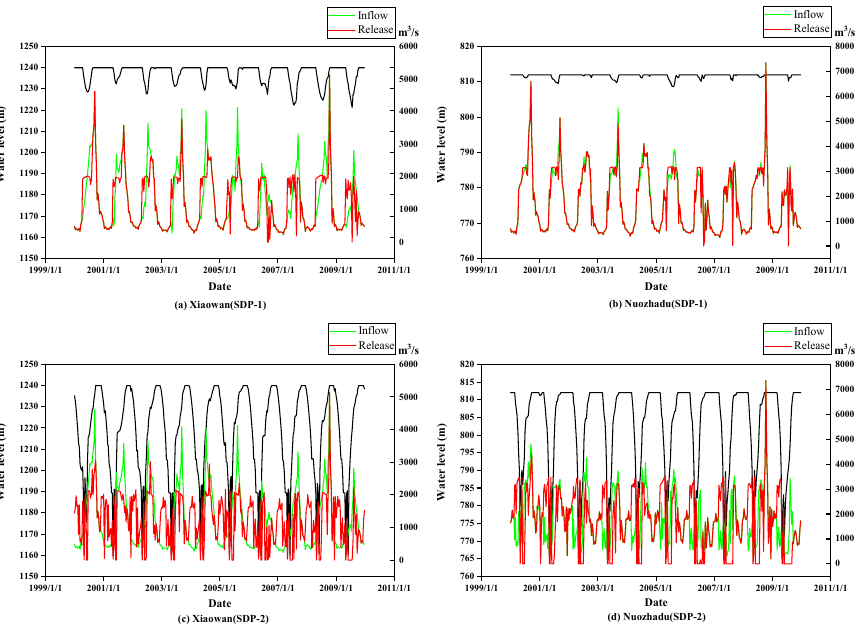
Figure 2. Water level, inflow, and release process of cascade reservoir for SDP-1 and SDP-2 during 2000–2009.